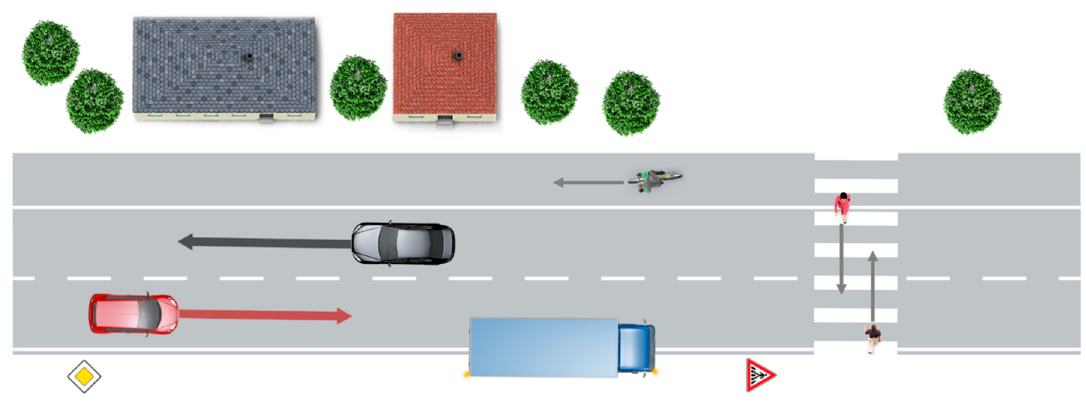
Figure 3. Dynamic and static characteristics of an urban road scenery. The dynamic influencing factors in this example include the AV (red) and additional moving HRU. The arrows represent the HRU’s trajectories. The parking lorry in the center is also part of the dynamic elements because it could potentially continue driving anytime.